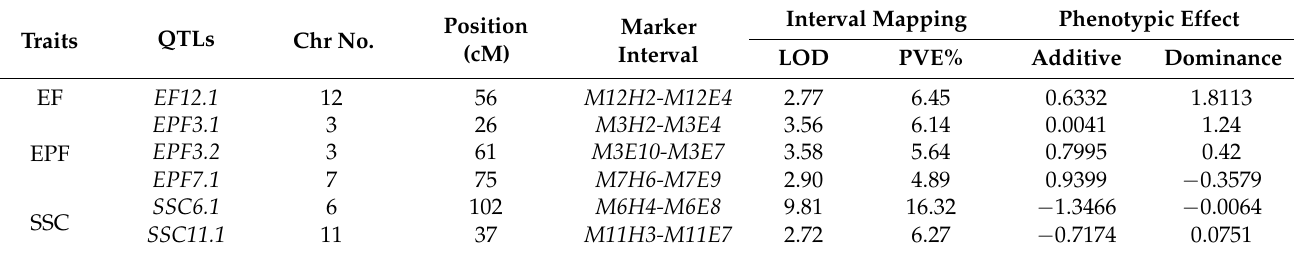
Table 5. QTLs information of EF, EPF, and SSC.